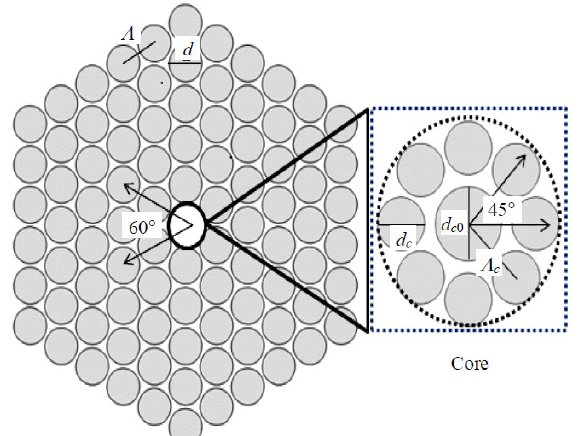
Fig. 1 Transverse cross-sectional view of the proposed